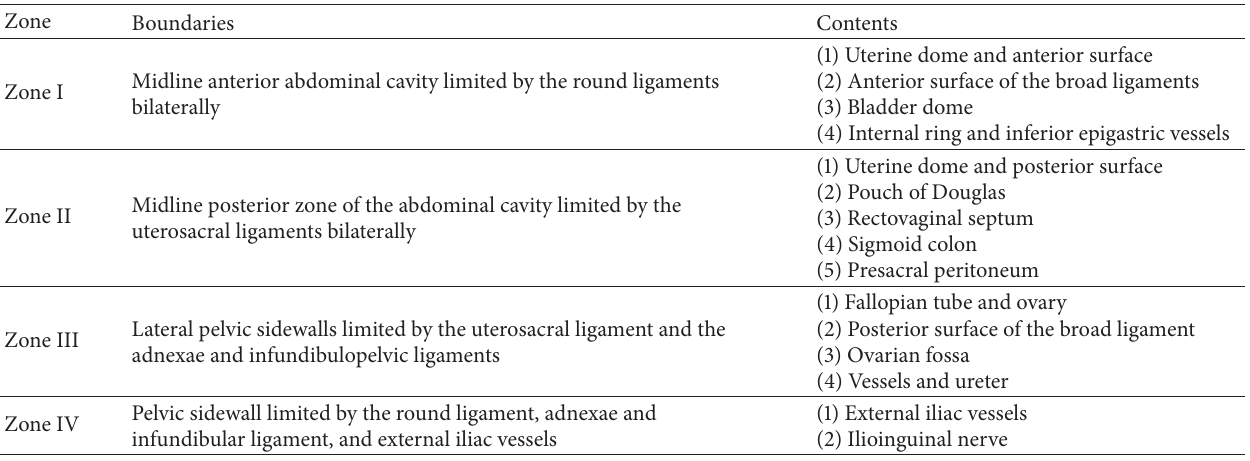
Table 1: Descriptive summary of the anatomical boundaries and the contents of each pelvic zone.